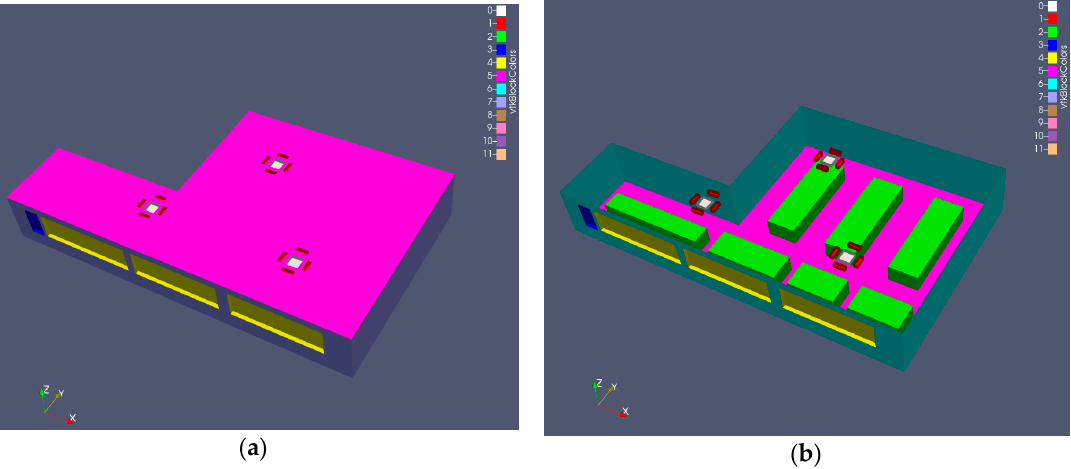
Figure 10. Room 411 boundary setting: ( a ) with ceiling; ( b ) without ceiling. Table 1. Boundary conditions of construction materials.